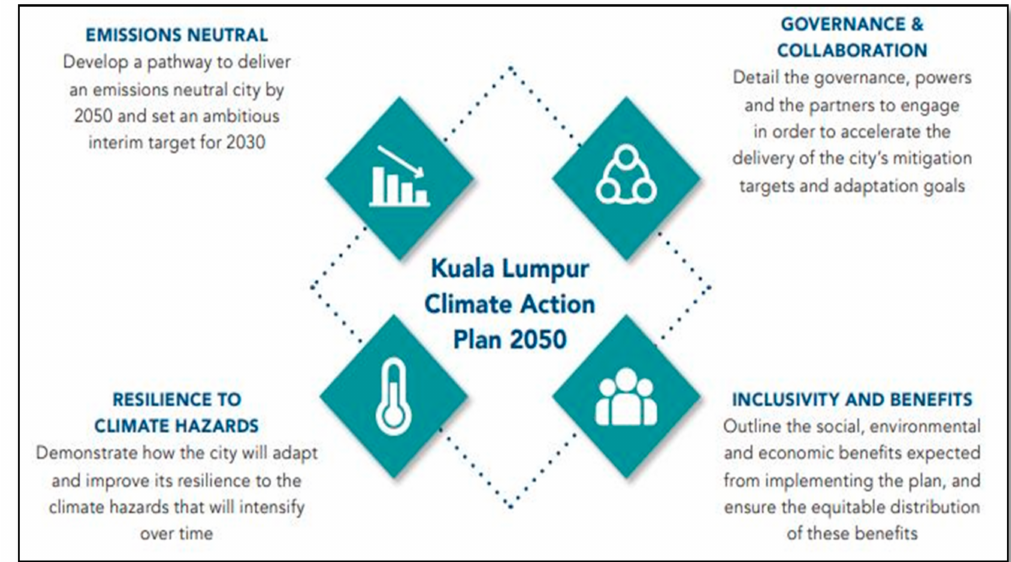
Figure 1. Key Components of the Kuala Lumpur Climate Action Plan 2050 [14].